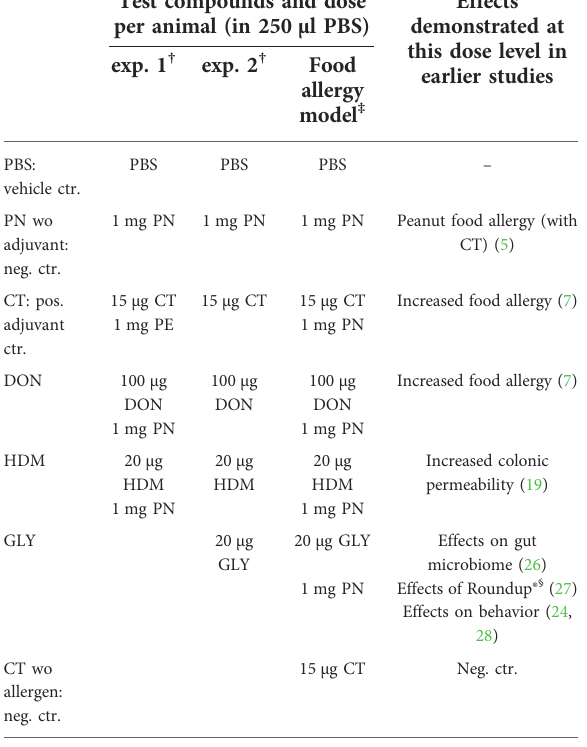
TABLE 1 Test solutions, doses (all oral exposures) and literature used to choose dose levels. Test compounds and